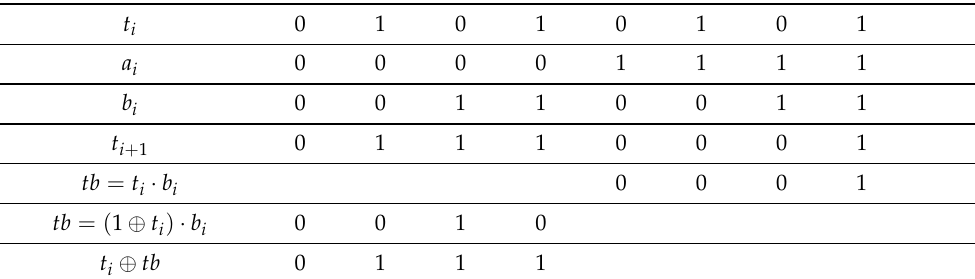
Table 2. Correctness of computing t i + 1